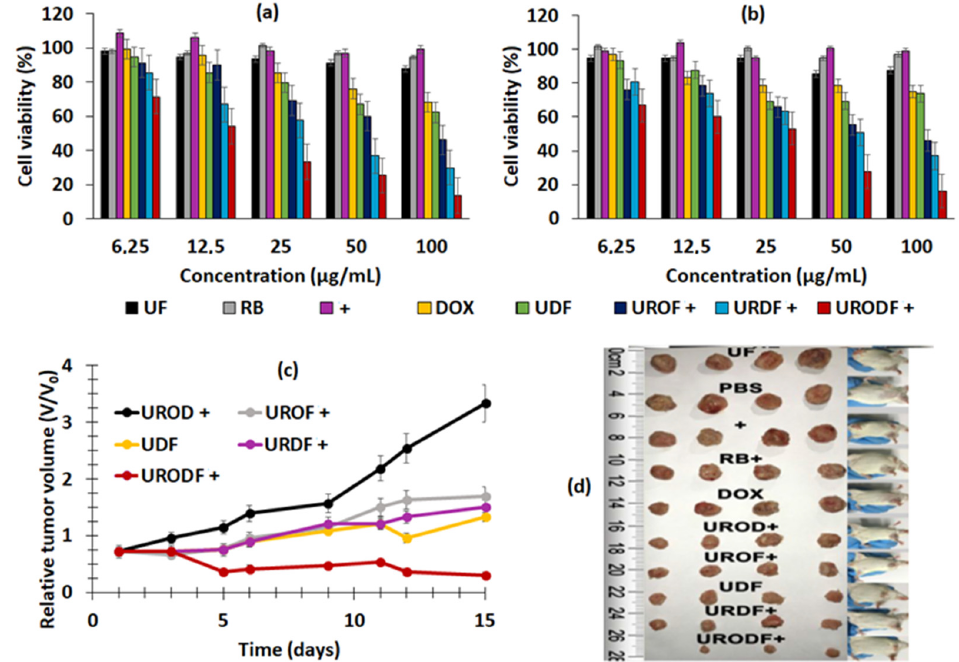
Figure 14. MTT assays for cell viability of ( a ) 4T1 and ( b ) HeLa cells incubated with different products and concentrations for 24 h. ( c ) Tumor volume growth curves and ( d ) dynamic body change of mice in groups receiving UROD+, UROF+, UDF, URDF+ and URODF+ treatments over a period of 14 days (+ = laser irradiation (808 nm, 0.5 W/cm 2 , 0 to 150 s)). Figures ( a – c ) adapted from Xie et al. [34]. Figure ( d ) reprinted with permission from Xie et al. [34]. Copyright 2019 American Chemical Society.